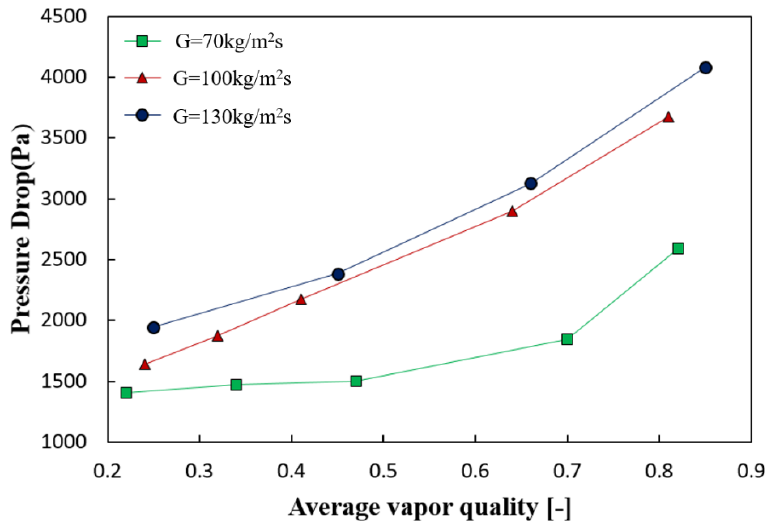
Figure 7. Variation of pressure drop according to mass flux at various vapor quality condition.